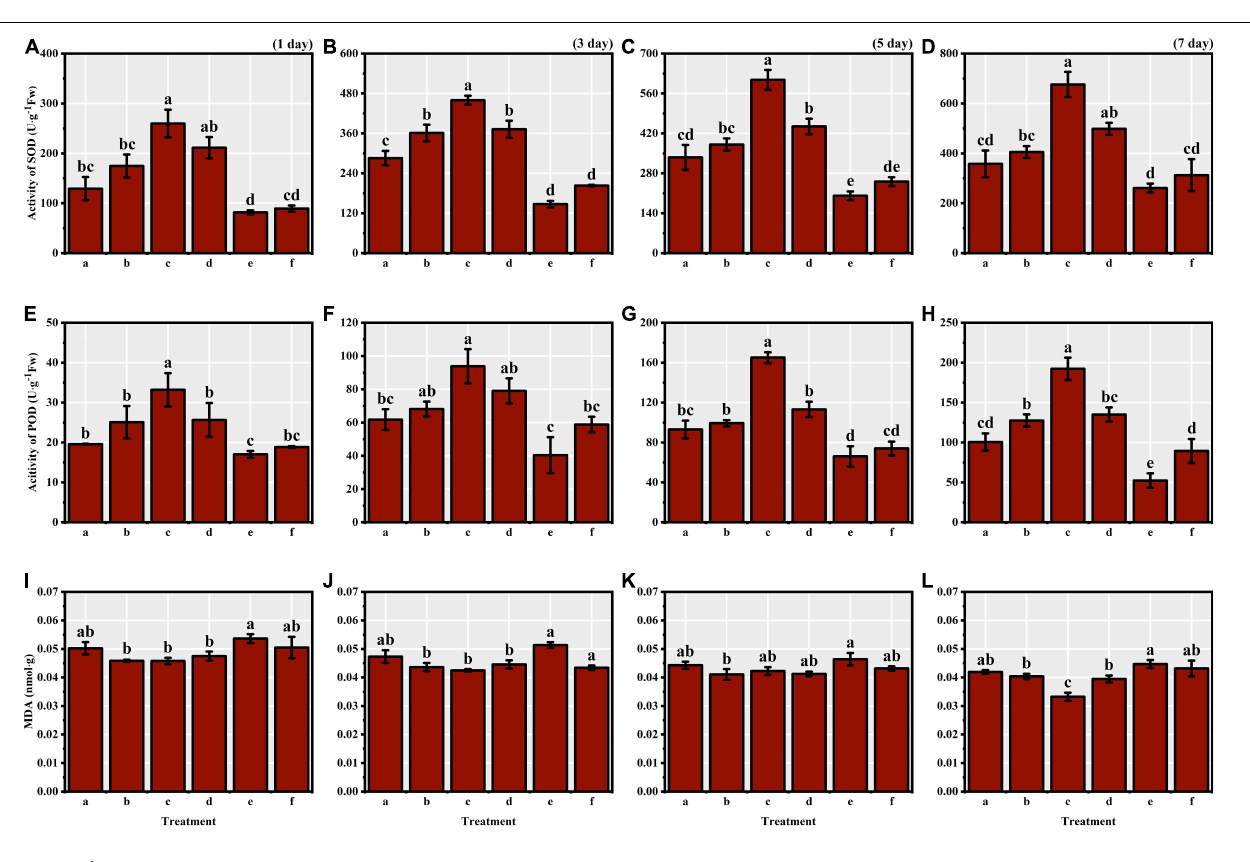
FIGURE 2 | The antioxidant enzymes’ activity and MDA content of Suaeda corniculata seeds under melatonin priming during the entire germination period (means ± standard errors, n = 3). Different letters indicate the significant differences at the 0.05 significance level. SOD, superoxide dismutase; POD,